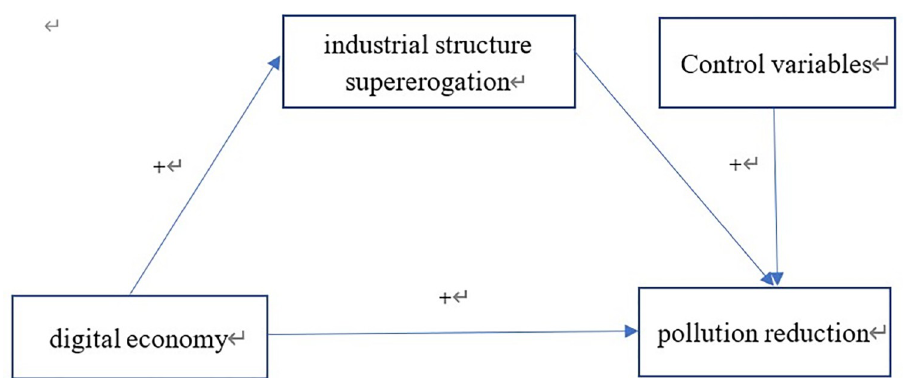
Fig 2. Hypothesized conceptual model and research